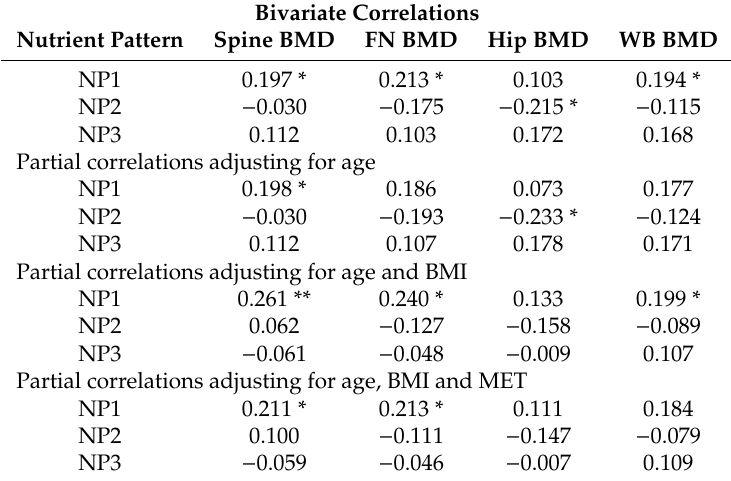
Table 3. Correlations of nutrient pattern scores and bone mineral density for 101 participants. Bivariate